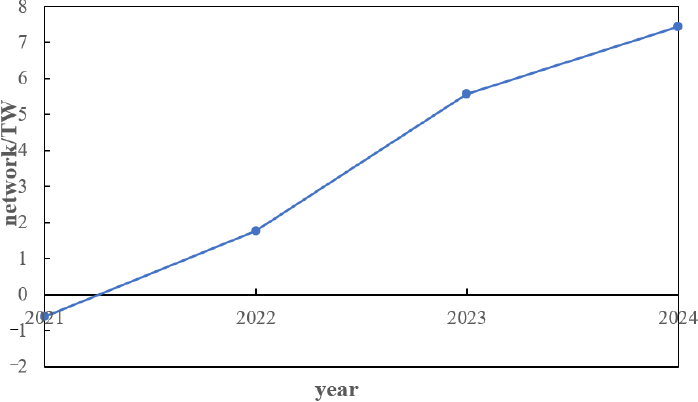
Figure 23. Interactive power between distribution network and main network from 2021 to 2024 years.